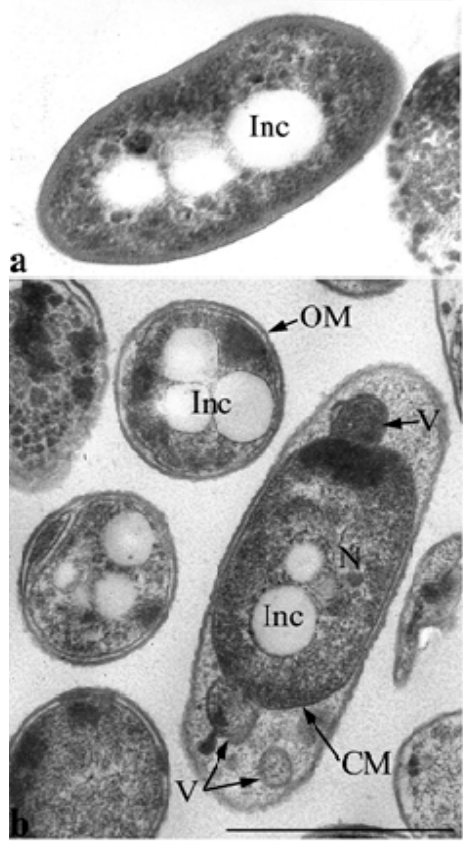
Figure 6. Transmission electron microscopy. ( a ) Ultrathin sections of P. putida Ch2 cells grown on LB agarized medium and ( b ) in MS1 medium with glyphosate as the sole source of phosphorus (inoculum). Designations: OM—outer membrane; CM—cytoplasmic membrane; V—vesicle; Inc—PHA inclusions; N—nucleoid. Bar =1 μ m.